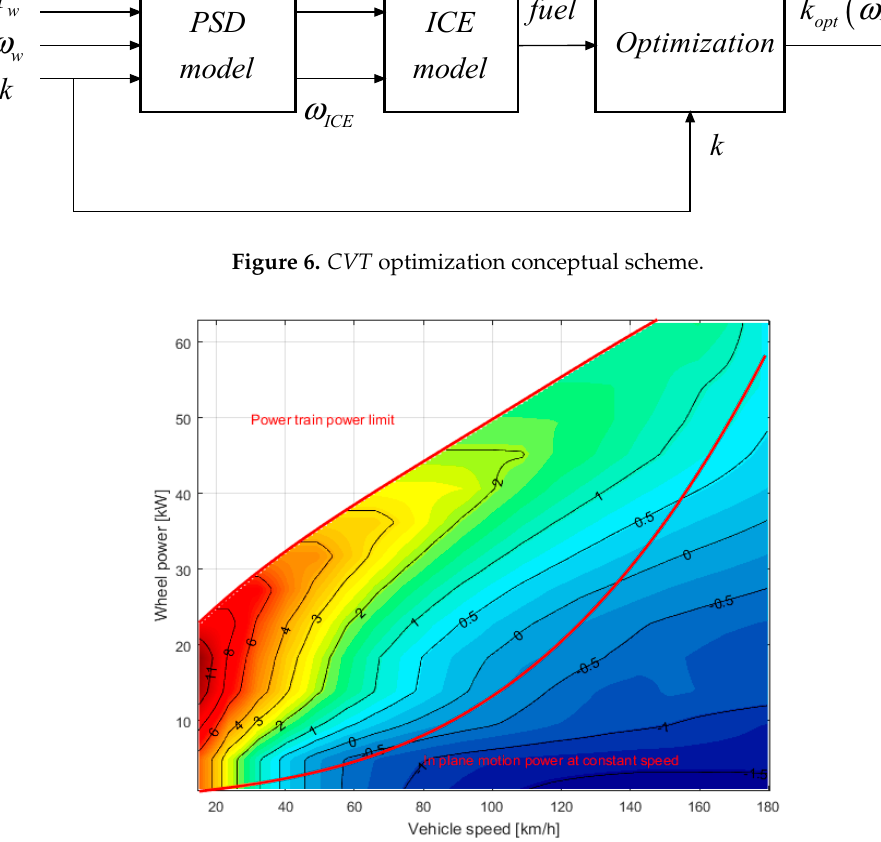
Figure 7. k steady state function for each operating condition— CVT .